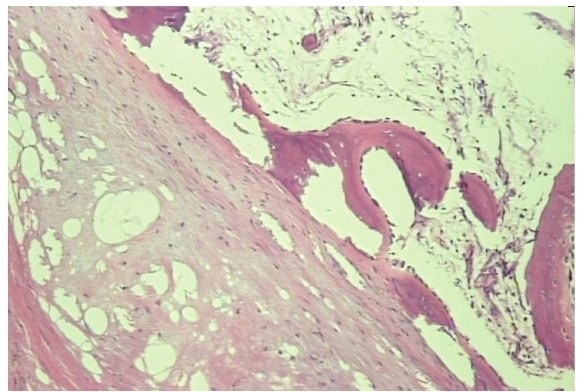
Figure 7: Area of osseous